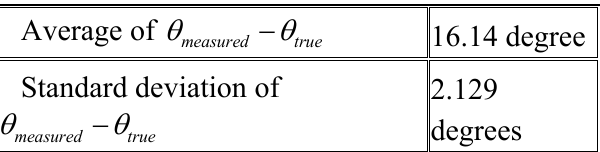
Table 3. Statistical results in the